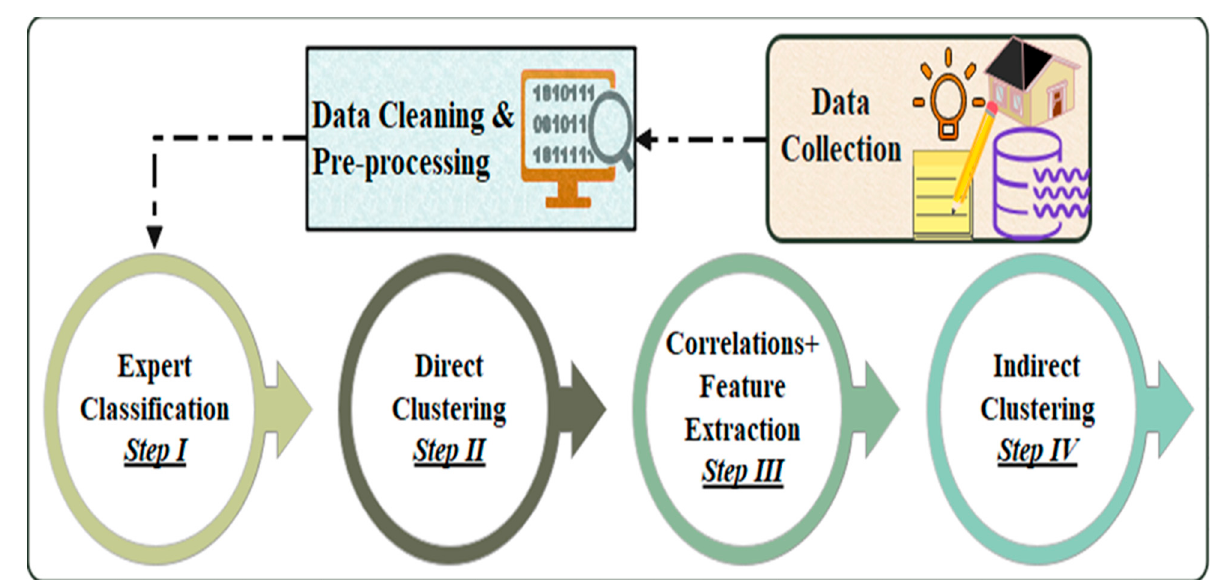
Figure 4. Proposed methodology for optimal consumer classification.